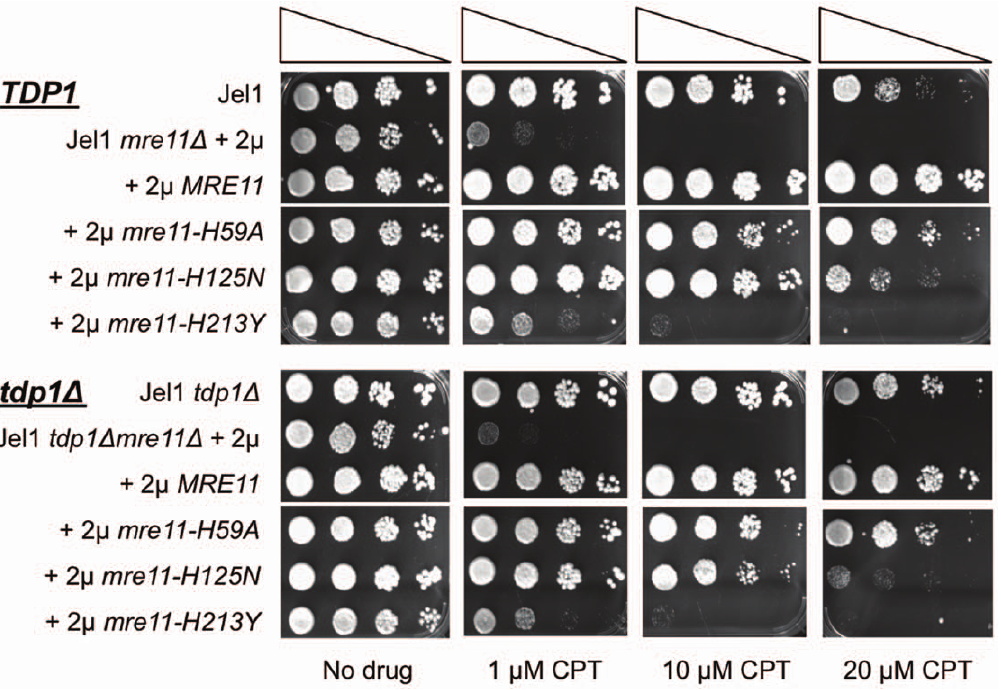
Figure 3. TDP1 does not contribute to CPT-resistance of MRE11 -deficient strains. Serial spot dilution assays of sensitivity to CPT of S. cerevisiae Jel1 TDP1 or Jel1 TDP1 mre11 D (above), and Jel1 tdp1 D or Jel1 tdp1 D mre11 D (below). The mre11 D derivatives were stably transformed with 2 m plasmid vectors, including empty vector (Jel1 mre11 D + 2 m ) or vectors expressing wild-type MRE11 (Jel1 mre11 D + 2 m MRE11 ) or indicated mutant alleles ( + 2 m mre11-H59A , + 2 m mre11-H125N , + 2 m mre11-H213Y ). Cells were spotted at 10-fold serial dilutions on rich plates containing no drug (left) or indicated concentrations of CPT.